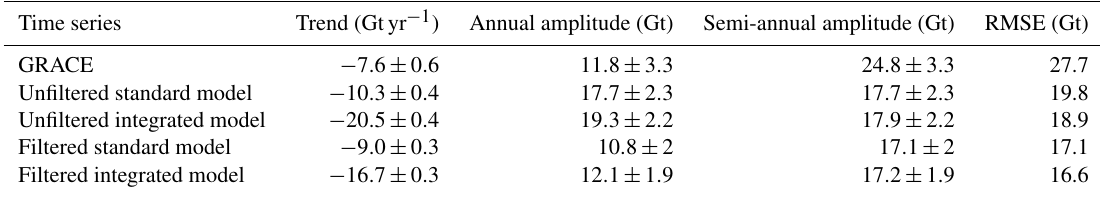
Figure 4. Time series of mass anomalies (mean removed: 2002–2016) in the Indus Basin derived from GRACE spherical harmonic solution (mean of JPL, CSR, and GFZ), corrected with ICE6G, and filtered with Swenson destriping and 300km Gaussian filter. Table 2. Summary of parameters from time series fitting of basin